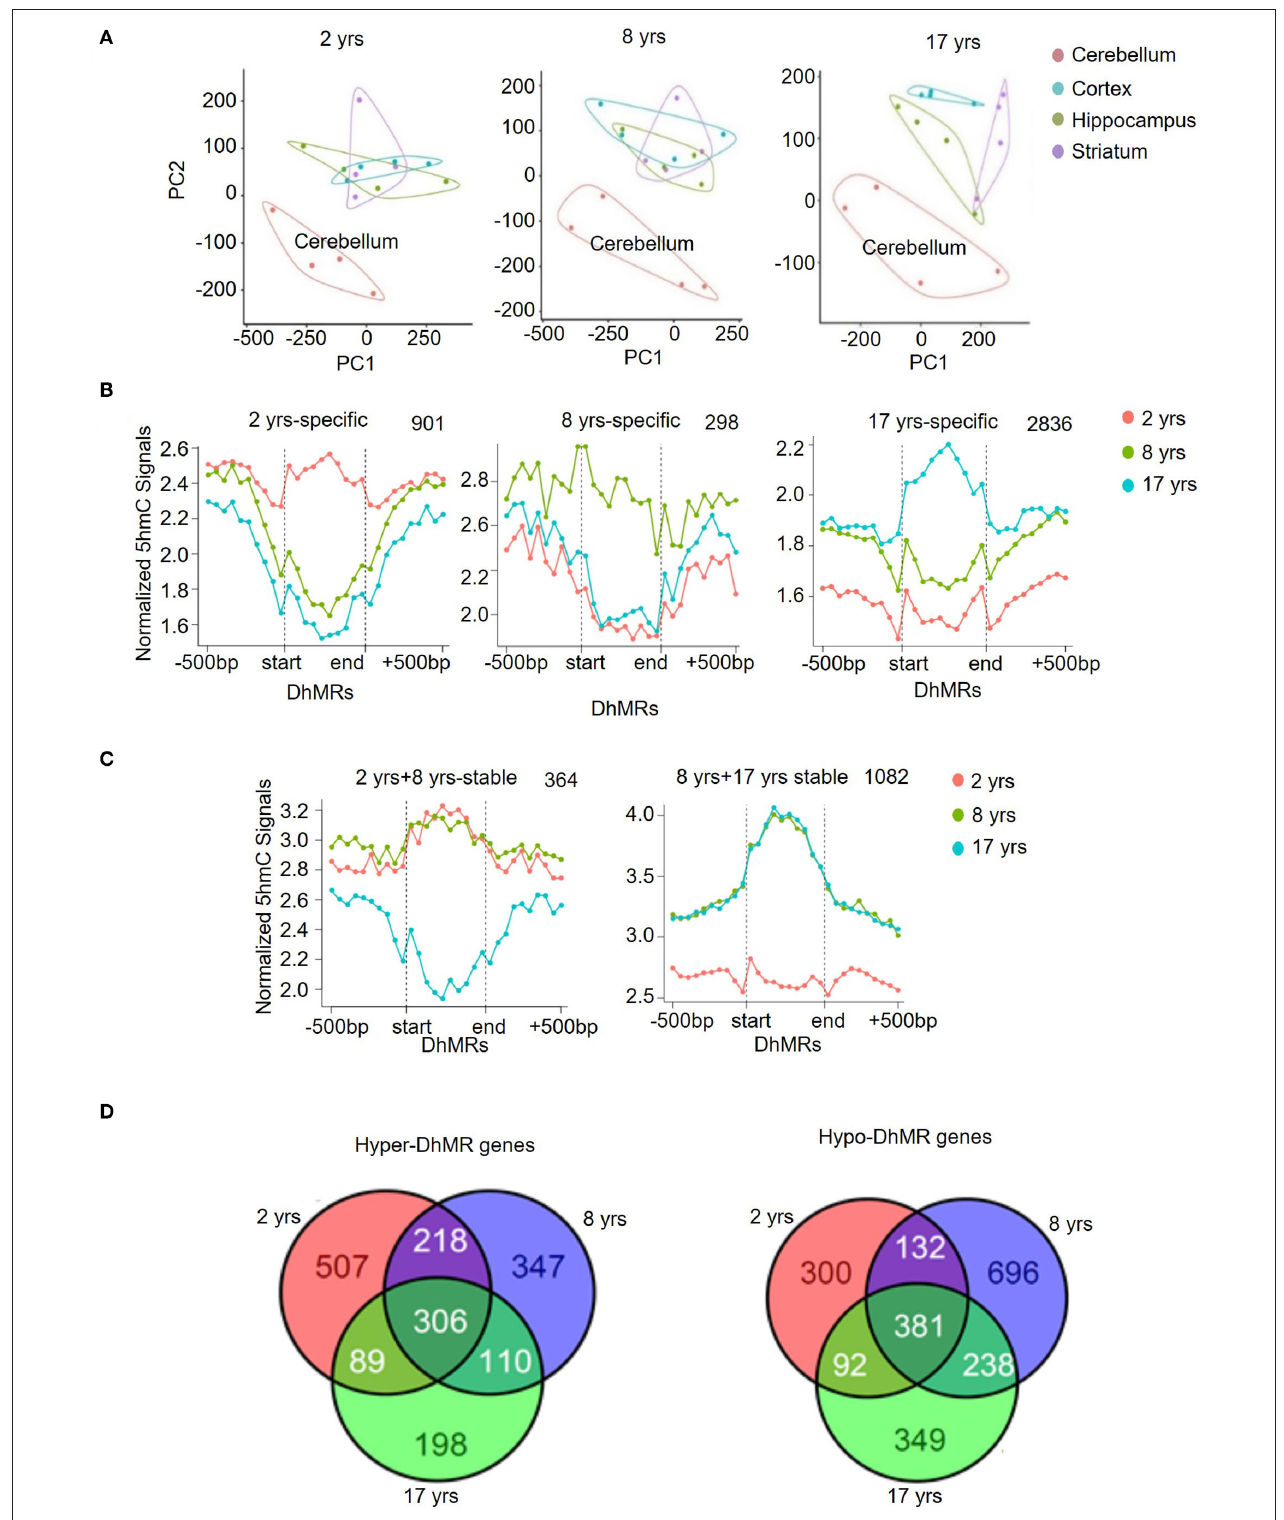
FIGURE 2 | Unique 5hmC pattern in the cerebellum. (A) PCA result of all samples. (B) PCA results for 2-, 8-, and 17-year-old monkeys. (C) Identification and characterization of cerebellum-specific dynamic DhMRs. A total of 901 DhMRs identified as juvenile specific relative to young and old groups, 298 DhMRs identified as young specific relative to juvenile and old groups, and 2,836 DhMRs identified as old specific relative to juvenile and young groups. (D) Identification and characterization of cerebellum-specific stable DhMRs. A total of 364 DhMRs were identified as juvenile and young stable relative to the old group and 1,082 DhMRs were identified as young and old stable relative to the juvenile group. The total numbers of DhMRs are indicated in the upper right-hand corner of each figure.